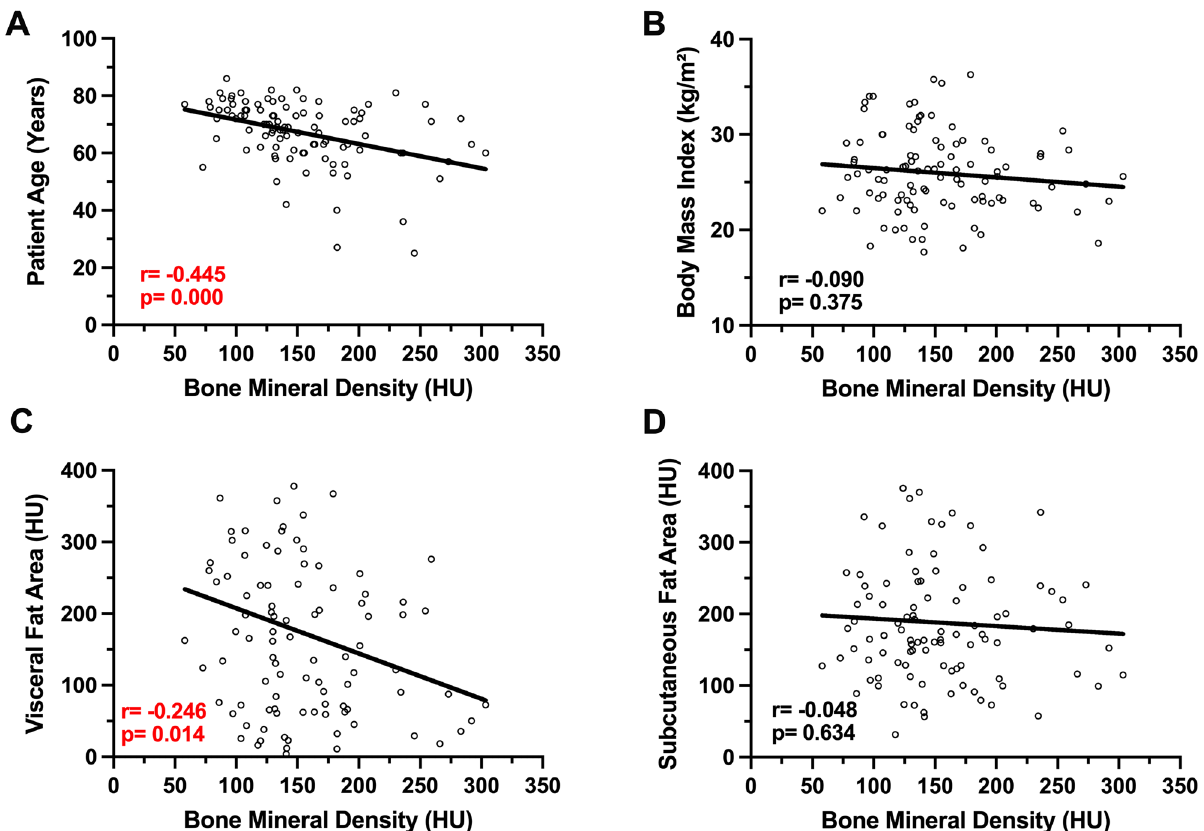
Figure 2. Correlation between bone mineral density and patient age ( A ), body mass index ( B ), visceral fat area ( C ) and subcutaneous fat area ( D ). Characteristics